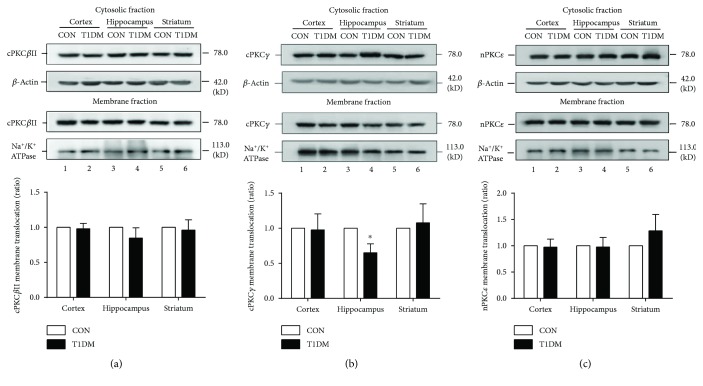
Membrane translocation of PKC isoforms in the cortex, hippocampus, and striatum at 2 weeks after STZ injection. (a) Representative and statistical results of Western blot analysis showed the membrane translocation of cPKCβII in the cortex, hippocampus, and striatum at 2 weeks after STZ injection. (b) Representative and statistical results of Western blot analysis showed the membrane translocation of cPKCγ in the cortex, hippocampus, and striatum at 2 weeks after STZ injection. (c) Representative and statistical results of Western blot analysis showed the membrane translocation of nPKCε in the cortex, hippocampus, and striatum at 2 weeks after STZ injection. ∗p < 0.05 compared with the CON group. n = 6 per group.